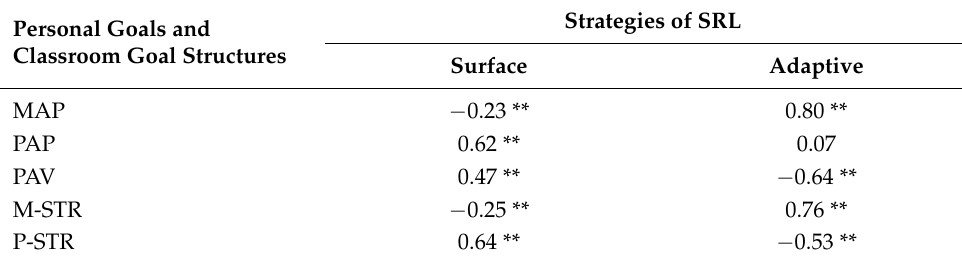
Table 2. Correlations of personal goals, classroom goal structures, and strategies of self-regulated learning. Personal Goals